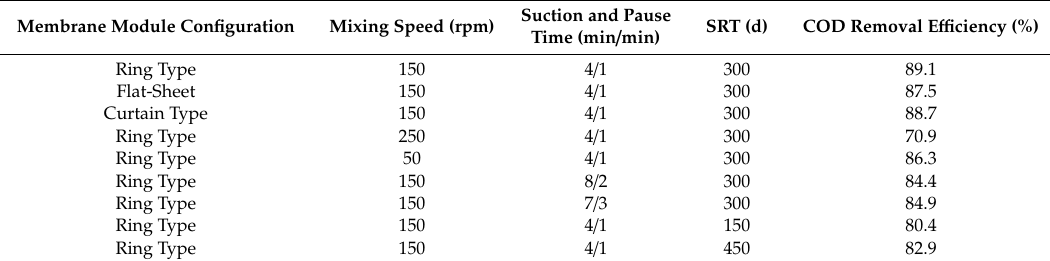
Table 1. Optimized operational parameters of the